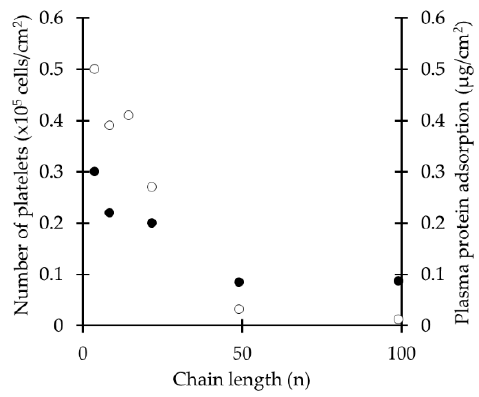
Figure 12. Effect of PEG chain length, immobilized to poly(methyl methacrylate) (PMMA) on platelet adhesion (•) and plasma protein adsorption (o). Data obtained from [57].